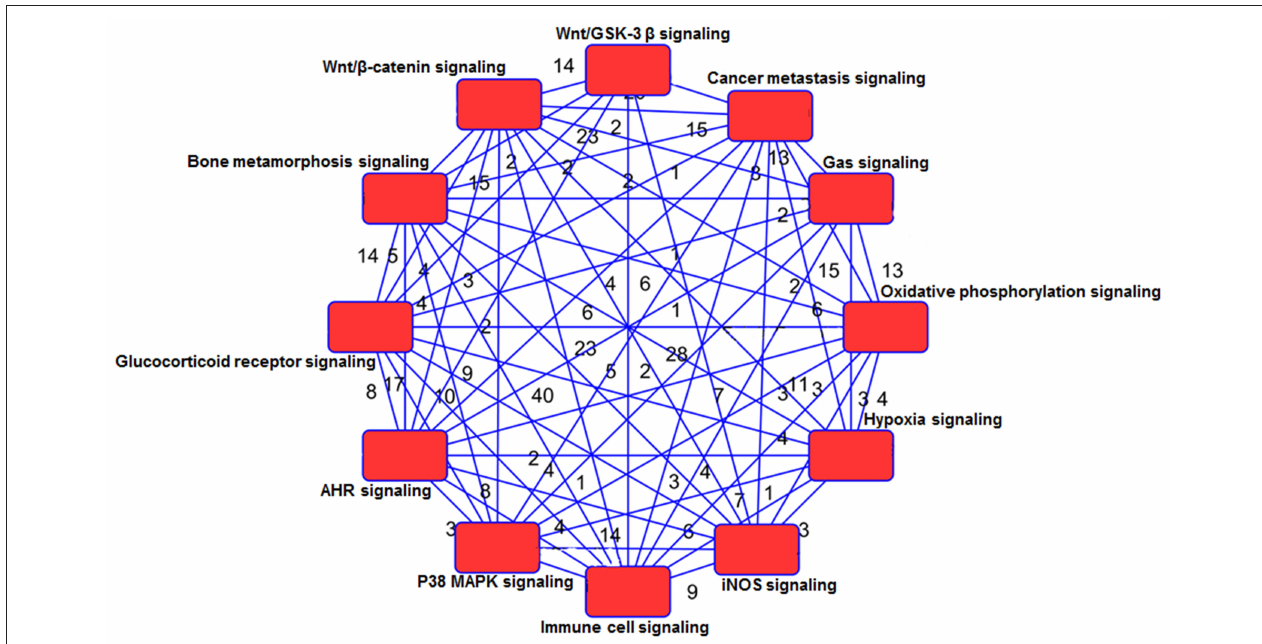
FIGURE 5 | Network analysis of genes and shared pathways in TRAMP mice . The red box depicts signaling pathways and the numerical values represent genes associated with other signaling network.